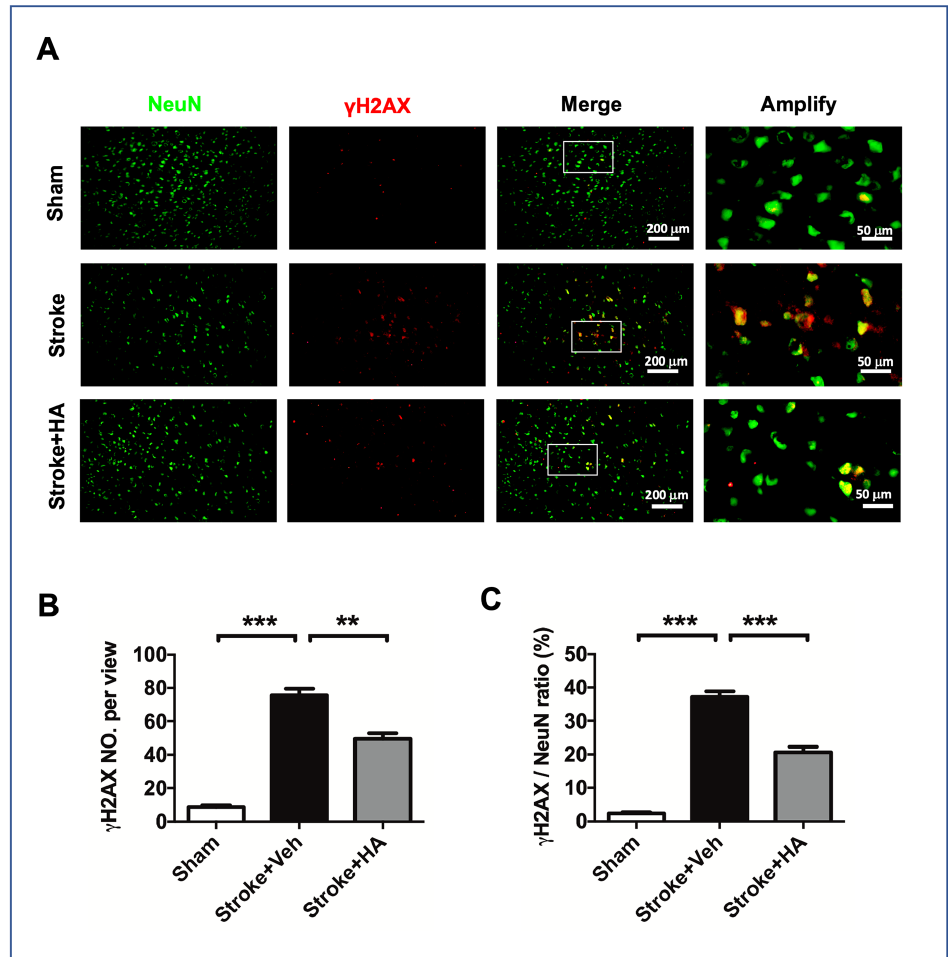
Figure 5 Figure 5. HA treatment attenuated neuronal DNA damage in the brain of rats after ischemic stroke. ( A ) Representative figures of immunofluorescent staining for NeuN and γ H2AX were conducted in rats with brain ischemia 3 days after stroke. ( B ) Quantified data of mean cell number with γ H2AX immunoreactivity in each view. ( C ) Quantified data of mean cell number with double-positive immunoreactivity of γ H2AX and NeuN in each view. Data quantification accumulated twenty image views across six brain sections per brain from cortex penumbra. n = 8. ** Denotes p < 0.01, *** denotes p <